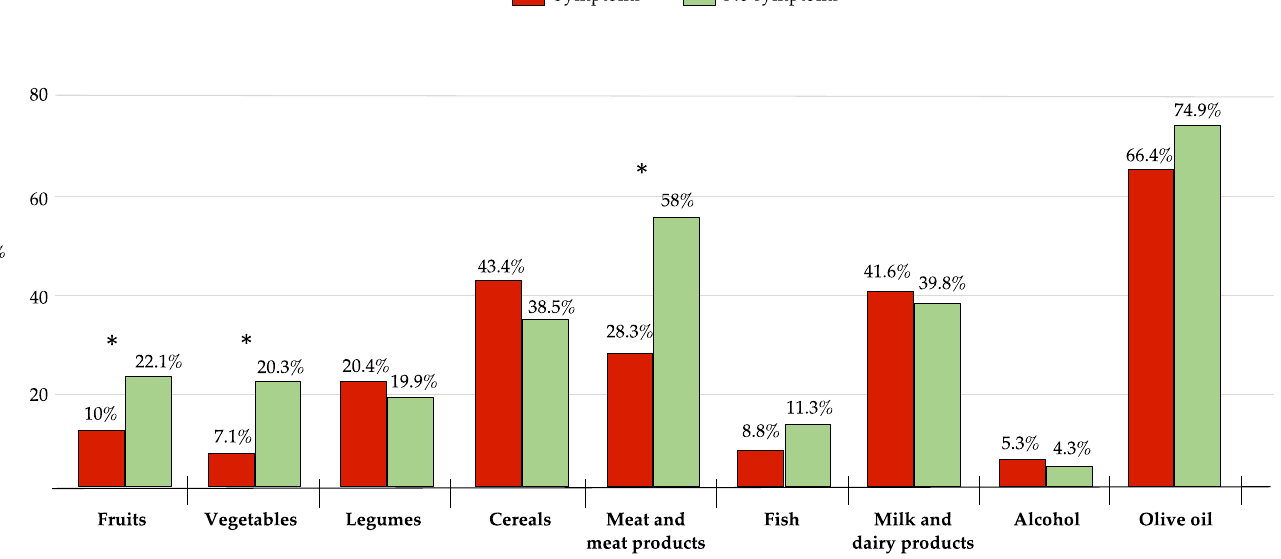
Figure 2. Percentage of participants reporting the optimal choice (i.e., the choice that gave 2 points) for the individual food components of the Medi-Lite score according to the presence (in red)/absence (in green) of symptoms of depression, anxiety, and stress (* p -value < 0.05).